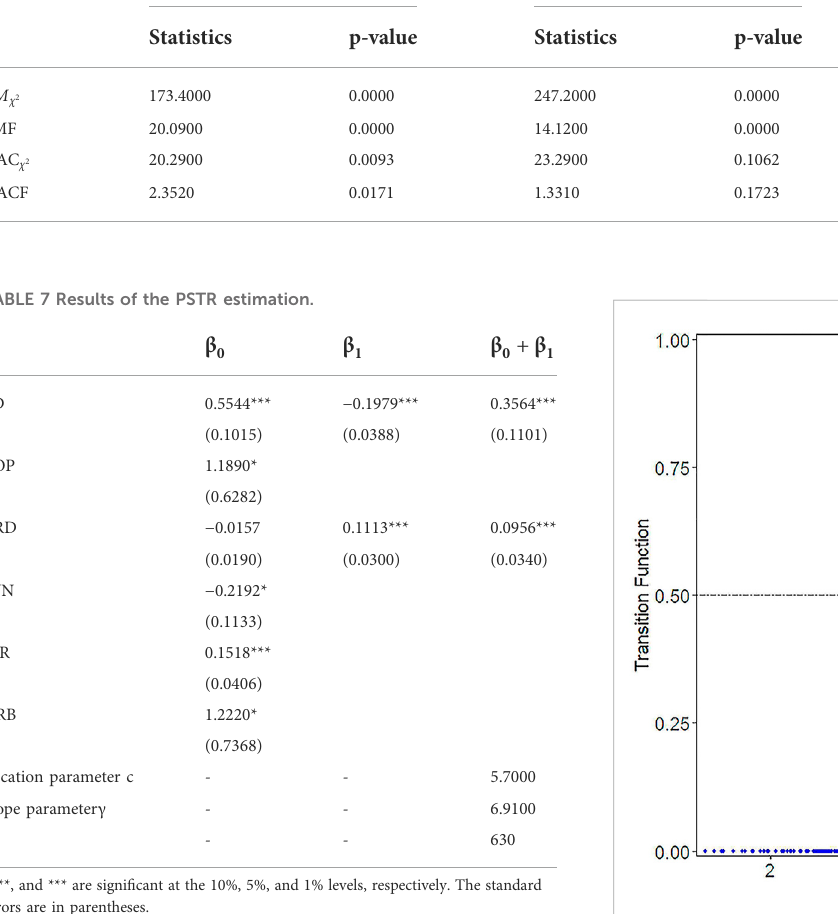
FIGURE 1 Smooth transition